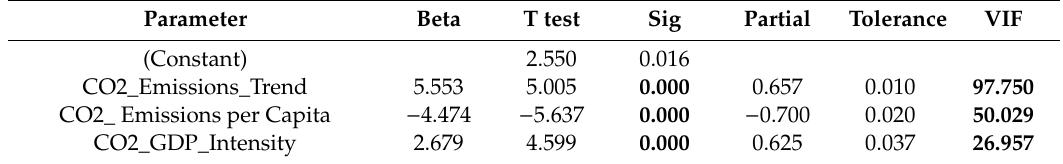
Table 19. Multicollinearity and partial correlation of parameters from the Environmental group. Parameter Beta T test Sig